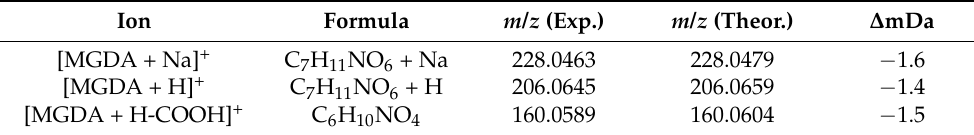
Table 4. Experimental and theoretical mass-to-charge ratios for measured MGDA forms. Ion Formula